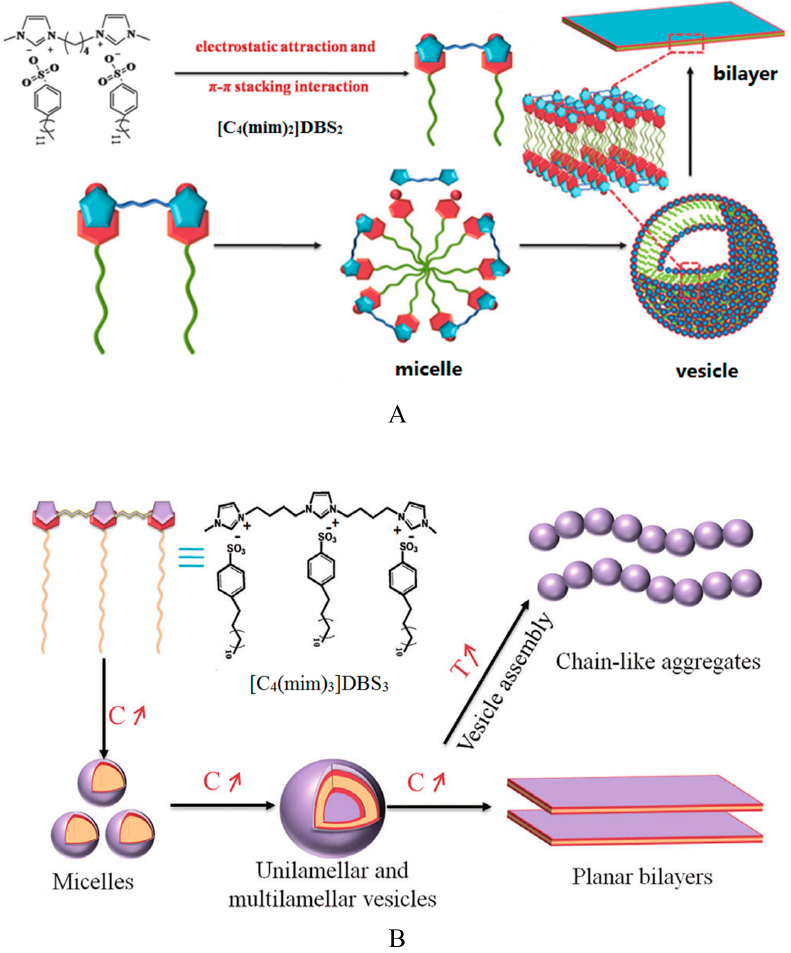
Figure 8. Dependence of the aggregate morphologies on the structure of the cation and anion in gemini ( A ) and trimeric ( B ) biamphiphilic surfactants.